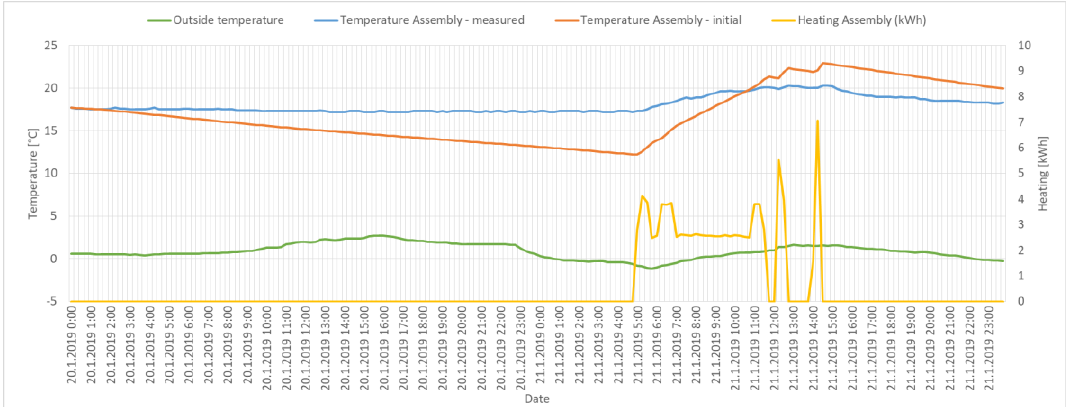
Figure 10. Results of optimized model with Winter-1 scenario.